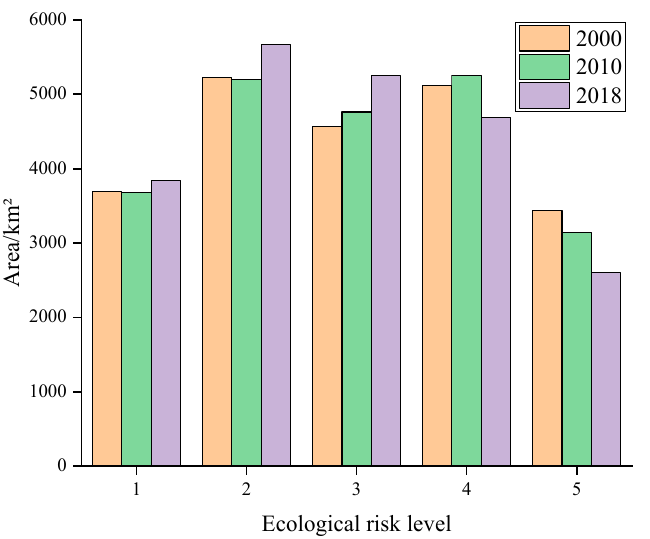
Figure 6. Area map of the ecological risk level in Nanning. Note: 1, 2, 3, 4, and 5 represent low-risk, low-medium-risk, medium-risk, medium-high-risk, and high-risk, respectively. From 2000 to 2018, Nanning’s overall ecological risk level was not high, but there were significant differences in the spatial distribution of each level of ecological risk (Figure 7). The spatial distribution of each ecological risk level was centered in the high ‐ risk areas and expanded to the low ‐ risk ones according to the ecological risk level. The high ‐